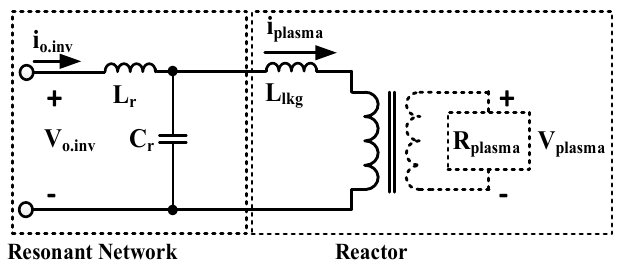
Figure 4. Conceptual circuit diagram of the LCL resonant network.